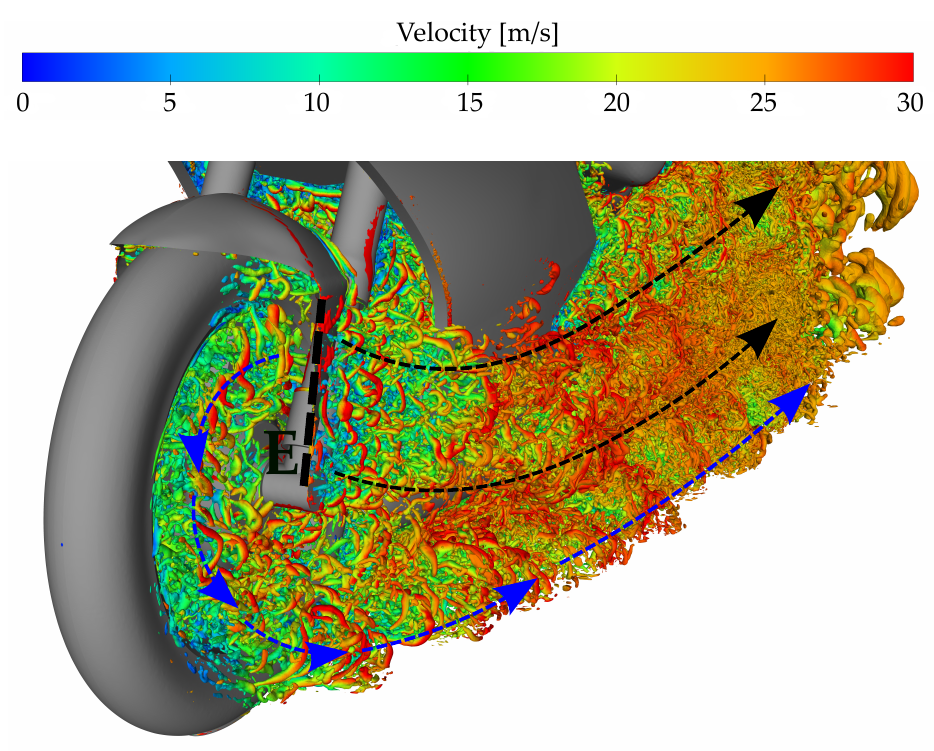
Figure 18. Contours of vorticity magnitude for the lower part of the motorbike at the following YZ planes: ( a ) 0.77 m in X direction, ( b ) 0.97 m in X direction, ( c ) 1.17 m in X direction and ( d ) 1.37 m in X direction.